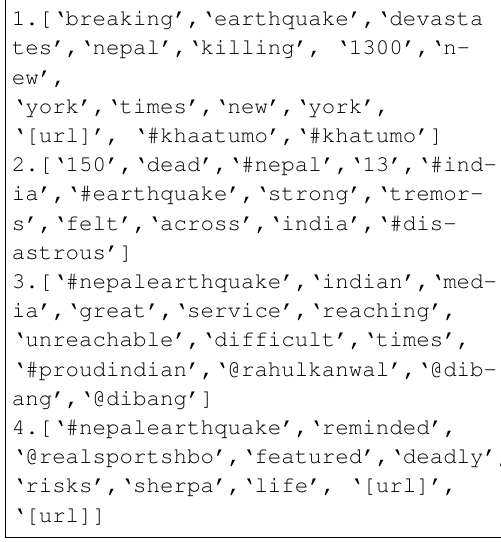
stemming, lemmatization and searching a word in a dic- tionary for replacement.